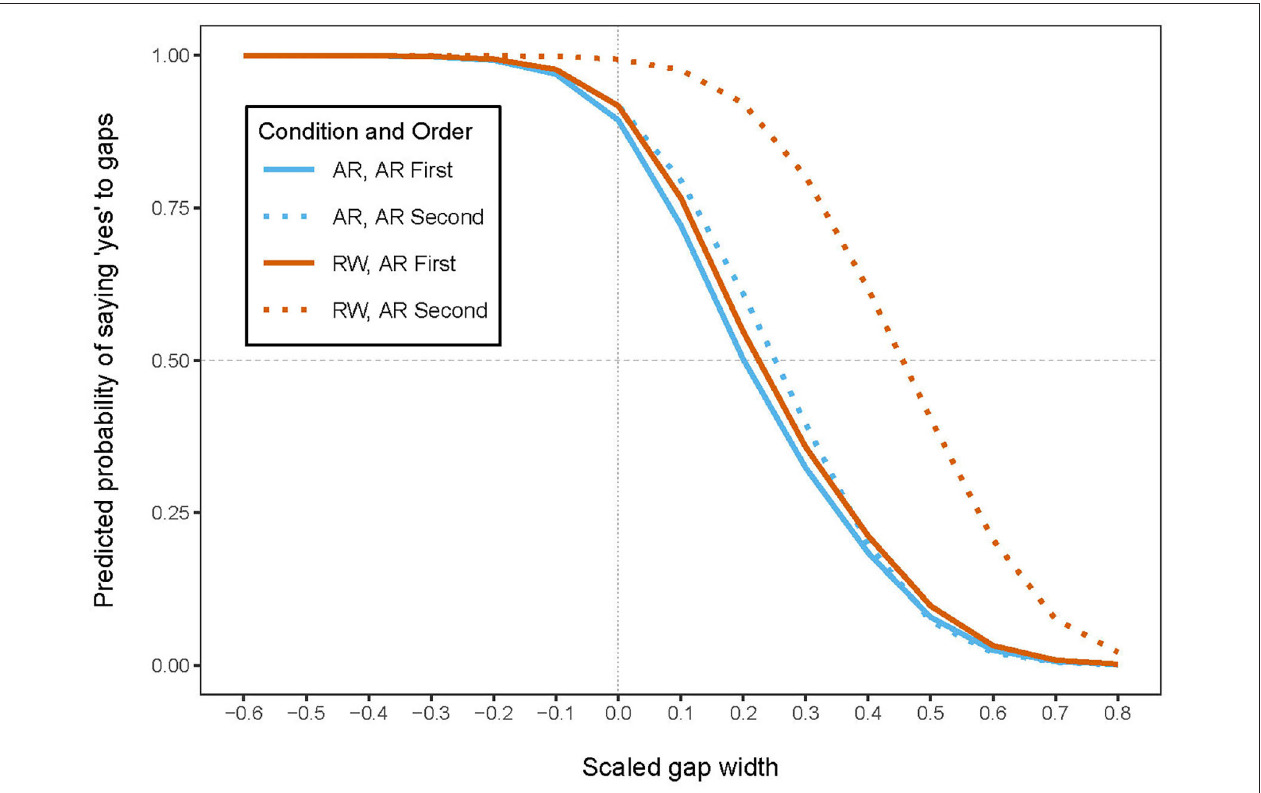
FIGURE 4 | Experiment 1 results. Predicted probability of saying “yes” to gap crossing as a function of scaled gap width for the AR condition (blue lines) and real-world condition (RW; orange lines) at two condition orders [AR experienced first (solid lines) and AR experienced second (dotted lines)]. The dotted line at x = 0.0 indicates when gap width = actual step length. The point of subjective equality (PSE) is the value of scaled gap width (on the x-axis) at which the curve intersects with y =